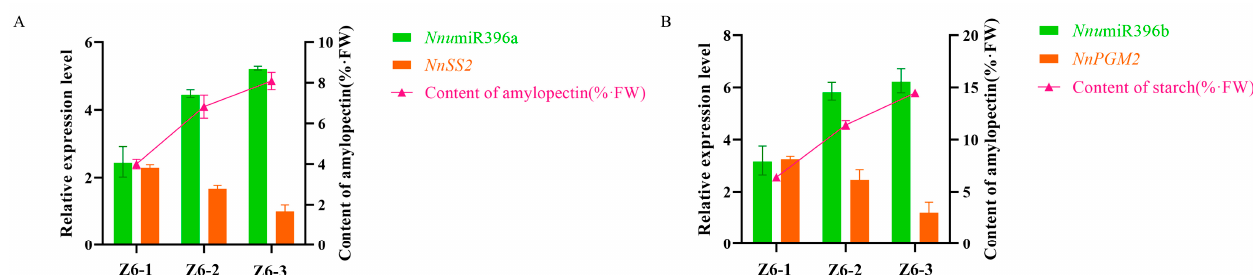
Figure 10. Expression pattern of two key miRNAs and their target genes and starch content in different internodes. ( A ) The expression pattern of Nnu miR396a and NnSS2 and the content of amylopectin. ( B ) The expression pattern of Nnu miR396b and NnPGM2 and the content of starch. NnTUA was used as the reference gene. All the data were calculated with three biological repeats. Error bars show SD from three biological replicates.